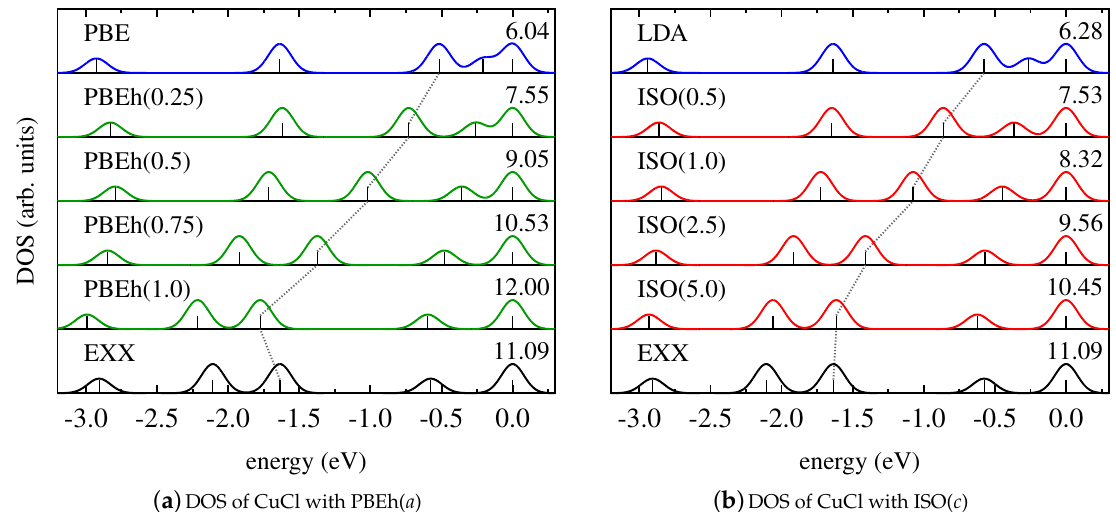
Figure 2. Kohn–Sham DOS of CuCl obtained with ( a ) PBE (blue), EXX (black), and PBEh in dependence on a (green); ( b ) LDA (blue), EXX (black), and ISO in dependence on c (red).